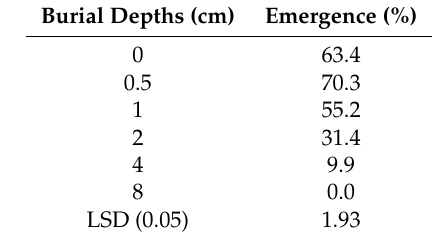
Table 1. The e ff ect of di ff erent burial depths on the seedling emergence of three biotypes of Brachiaria eruciformis . Each value of the table represents a mean value of the germination data (pooled across biotypes), as no significant di ff erences were observed among